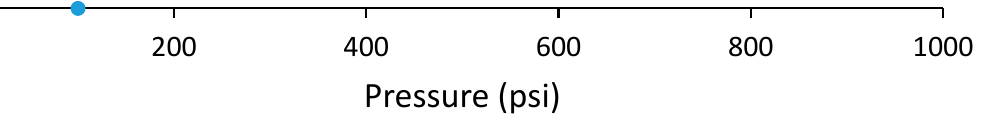
Figure 2. Determination of the optimal operating pressure for the treatment of each feedstock. The optimal operating pressures for the treatment of the LF-digestate and the LF-pig slurry were 500 and 400 psi, respectively. For the LF-digestate, an increase in pressure higher than 500 psi did not have any significant effect on the permeate flow rate. In the case of the LF-pig slurry, the optimal working pressure was selected taking into account that the VSEP system needs a minimum recirculating flow rate for the pump and this recirculating flow rate was 0 at working pressures higher than 400